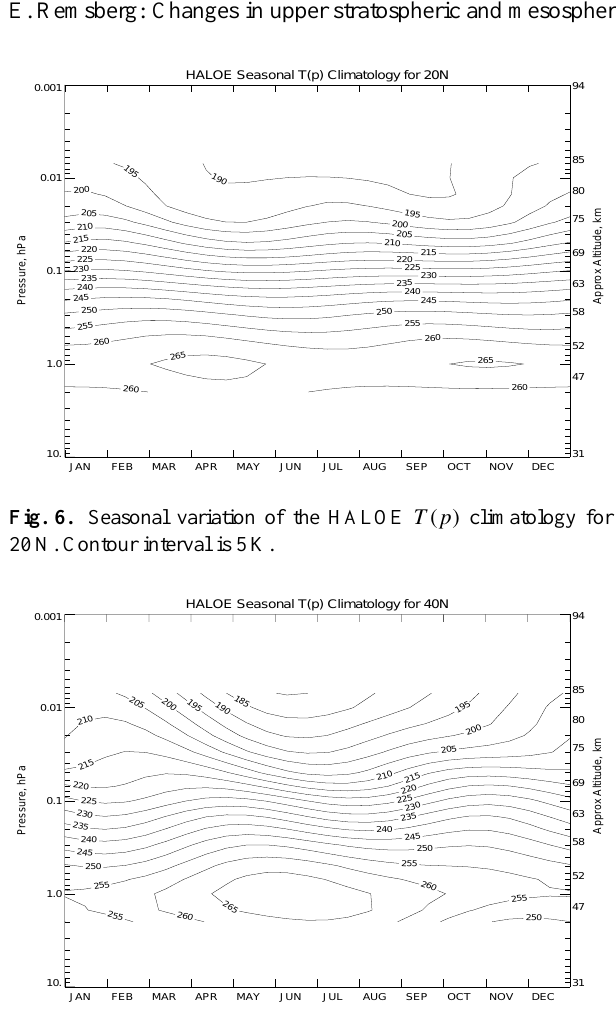
Fig. 7. As in Fig. 6, but for 40N.